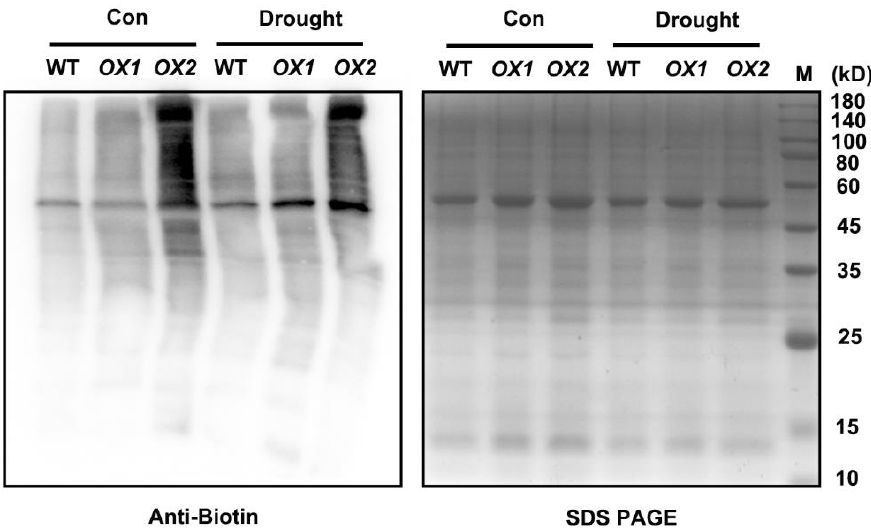
Figure 4. OsLCD1 -mediated persulfidation of rice total protein. Fourteen-day-old rice seedlings of wild-type (cv. Wuyunjing 7, WT), OX1 , and OX2 were isolated from cultivated culture and placed in filter paper for dehydration for 3 h. Afterward, proteins were extracted from 0.2 g of leaves and subjected to the modified biotin switch method, and the labeled proteins were detected using protein blot analysis with antibodies against biotin. Coomassie brilliant blue-stained gels were presented to show that equal amounts of proteins were loaded. Numbers on the right of the panels indicate the position of the protein markers in kDa.